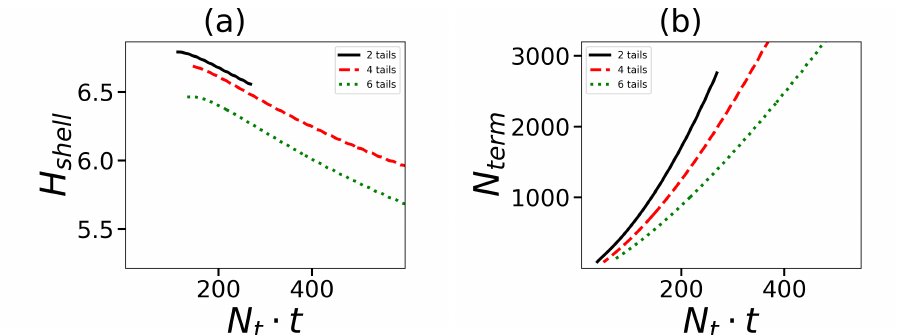
Figure 7. ( a ) The size of shell H shell of micelle corona (corona thickness) and ( b ) the number of terminal groups of dendrons in the micelle as a function of the overall number of units in tails N t · t . All cases correspond to the same generation number G =